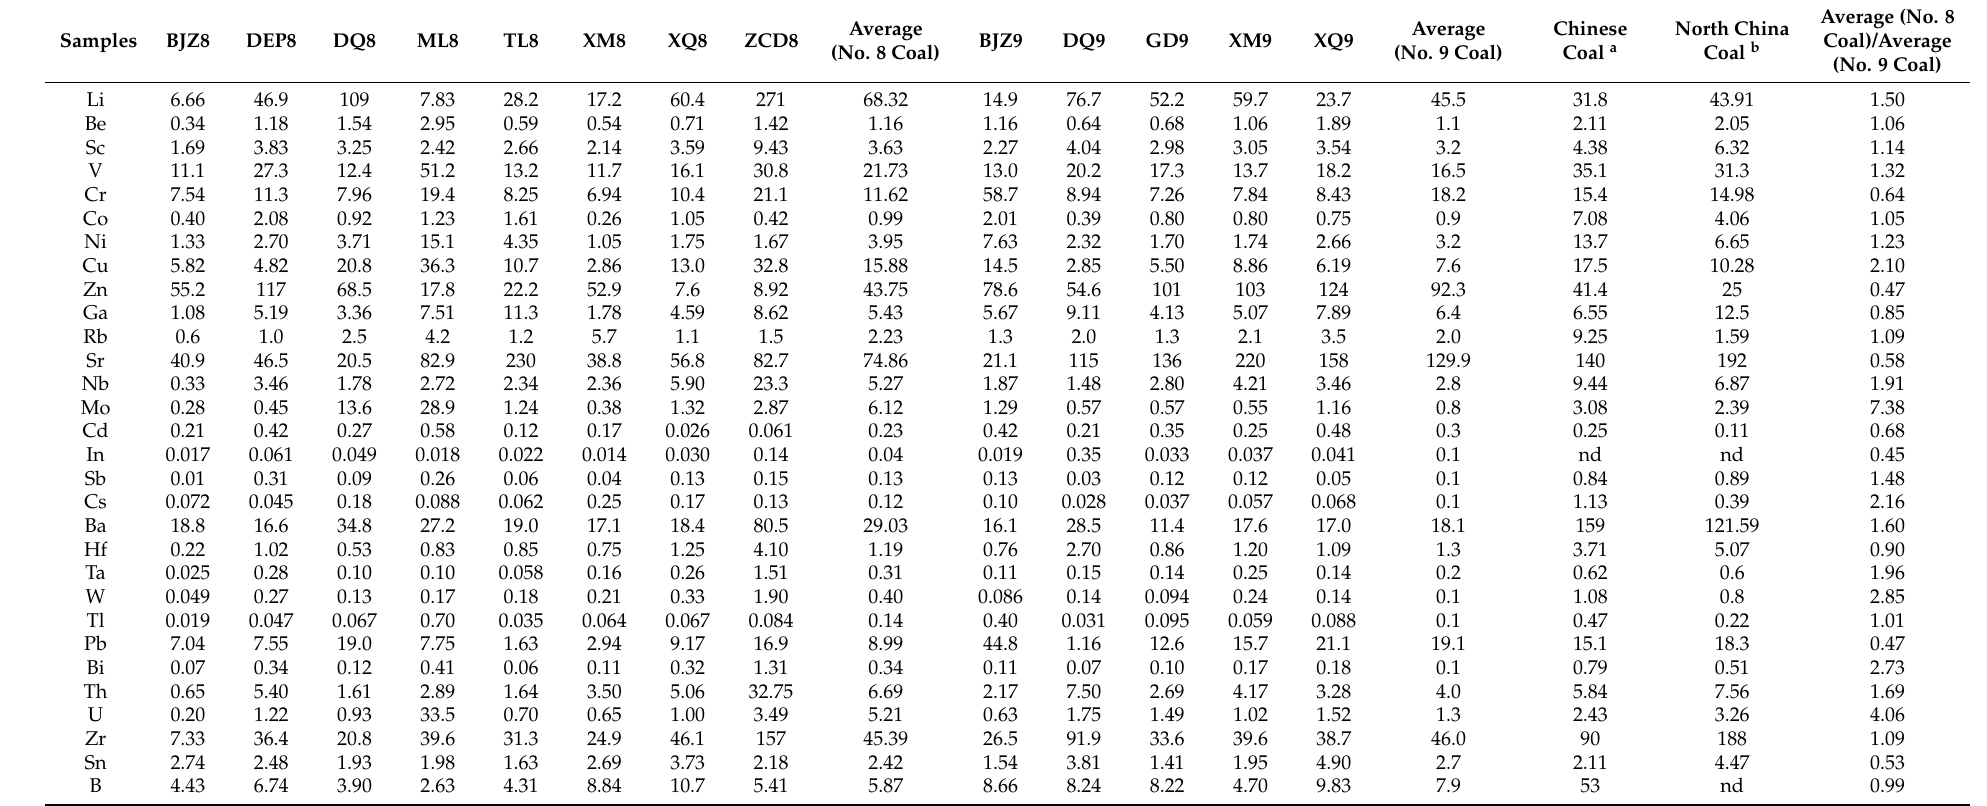
Table 5. Trace elements content in coal samples ( µ